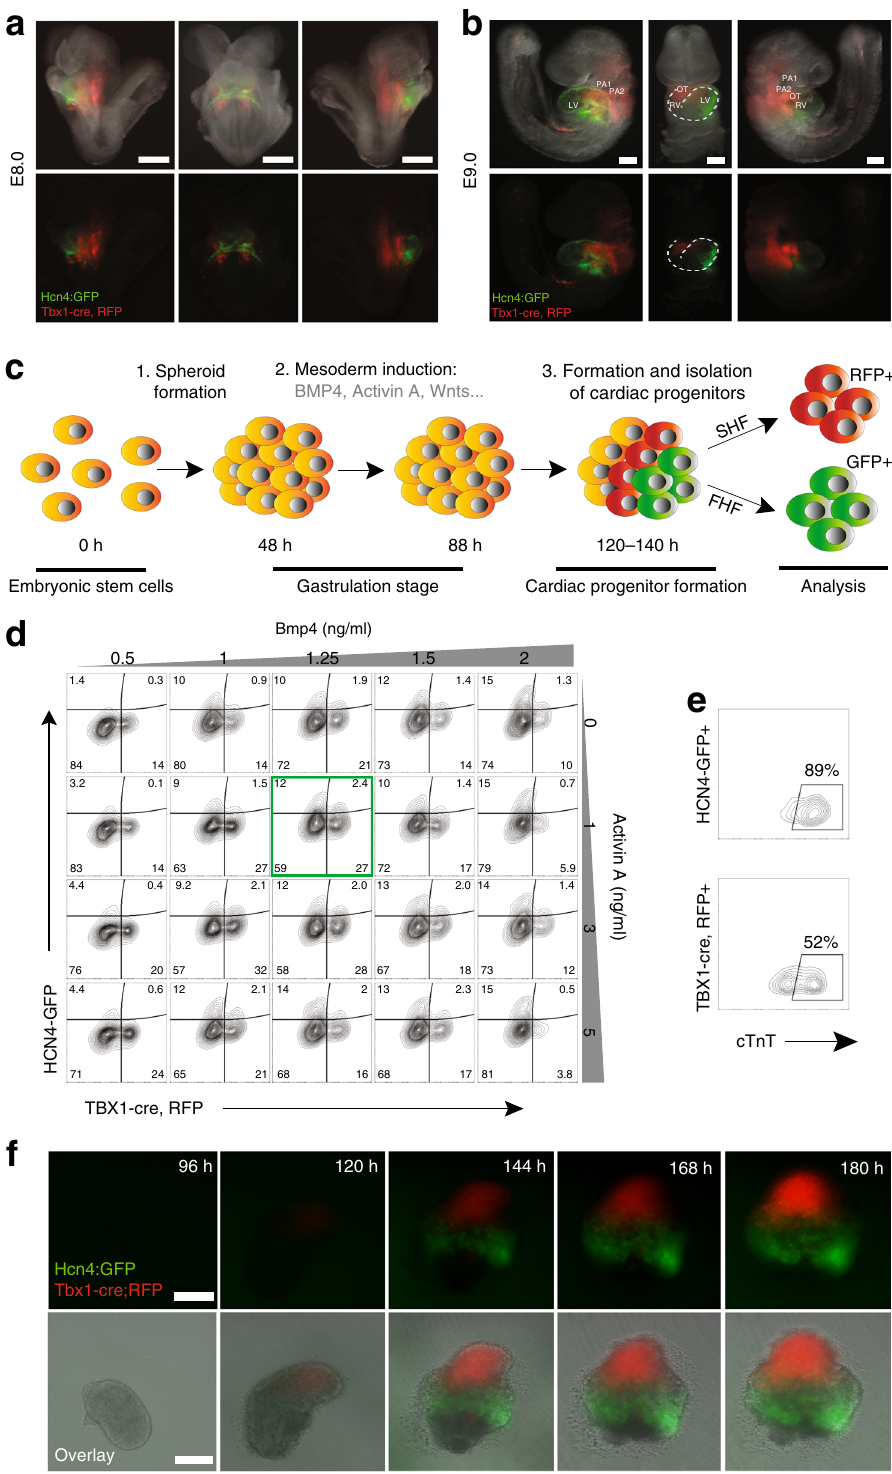
Fig. 1 FHF/SHF-like cells are induced in spheroid PSC culture. a Live imaging of Hcn4-GFP, Tbx1-Cre, Ai9 mice E8.0. GFP is exclusively expressed in the cardiac crescent and primitive myotube, whereas RFP is expressed in the posterior region. b Live imaging of Hcn4-GFP, Tbx1-Cre, Ai9 mice E9.0. GFP expression is restricted to the LV and atria whereas RFP is expressed in the pharyngeal region posterior to the heart, the out fl ow tract and RV. c Schematic of the strategy used to generate and differentiate ESC-derived cardiac spheroids. d Flow cytometric analyses of Hcn4-GFP + and Tbx1-Cre, RFP + in cardiac spheroids after 5.5 days of differentiation. e Flow cytometric analyses of GFP + /cTnT + and RFP + /cTnT + cells at day 9 in cardiac spheroids. f Representative images from live imaging time-lapse experiments of a differentiating cardiac spheroid. White scale bars indicate 100 μ